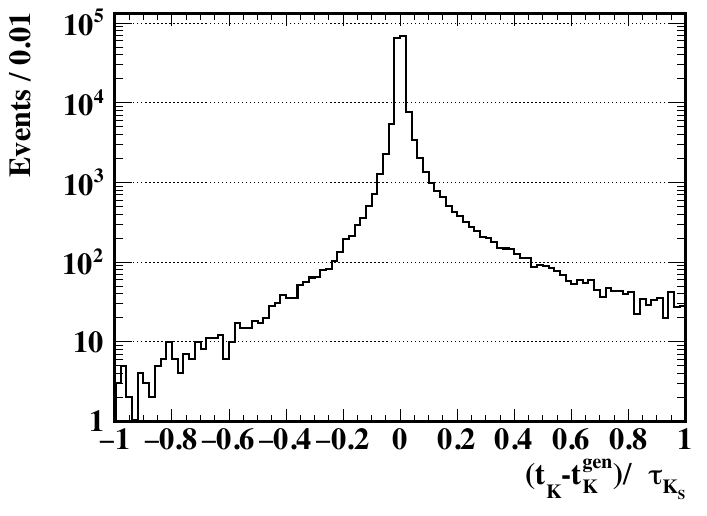
Figure 5 . Resulting kaon lifetime resolution.